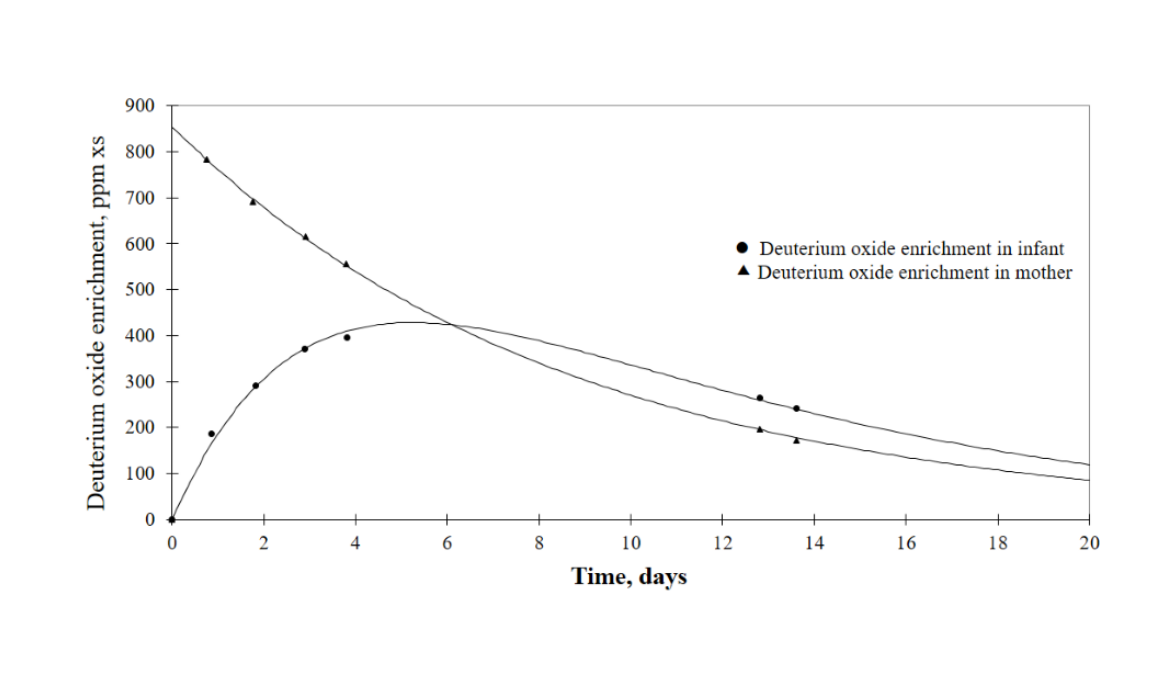
Figure 2. Deuterium oxide enrichment from the deuterium oxide dose-to-mother technique to measure breast milk intake shows the disappearance of deuterium oxide from the mother's body and the presence of deuterium oxide in the infant. xs: